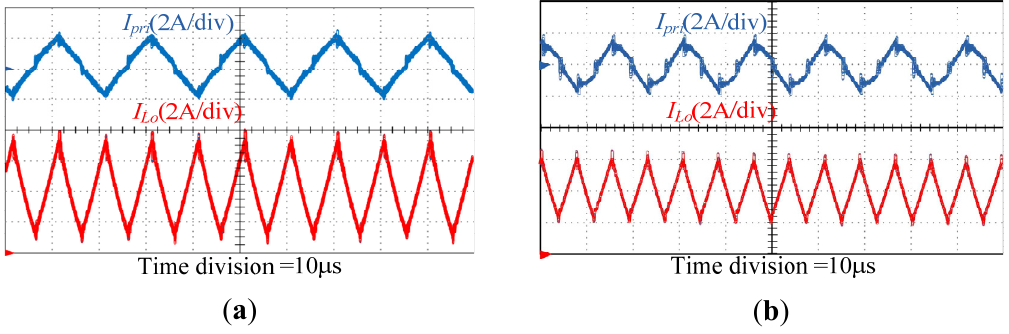
Figure 26. Current waveforms of magnetic components currents under 20% of full load ( a ) Conventional converter at f s = 50 kHz; ( b ) Proposed converter at f s = 65